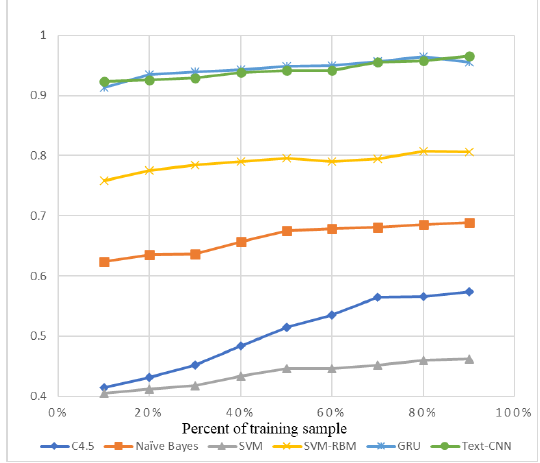
Figure 8. F1-score of KDD99-DOS.